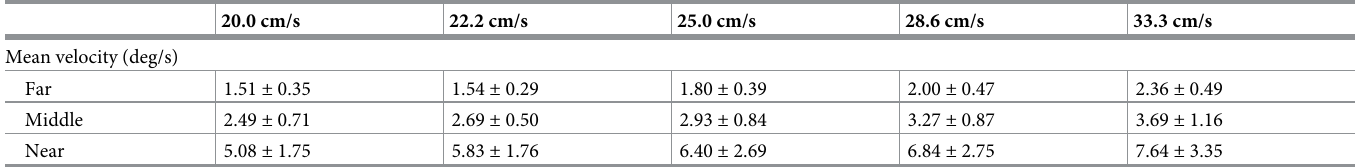
Table 1. Mean values ( ± SD) of the mean velocity of convergence eye movements from 100 to 400 ms after the motion onset at each target velocity in three different